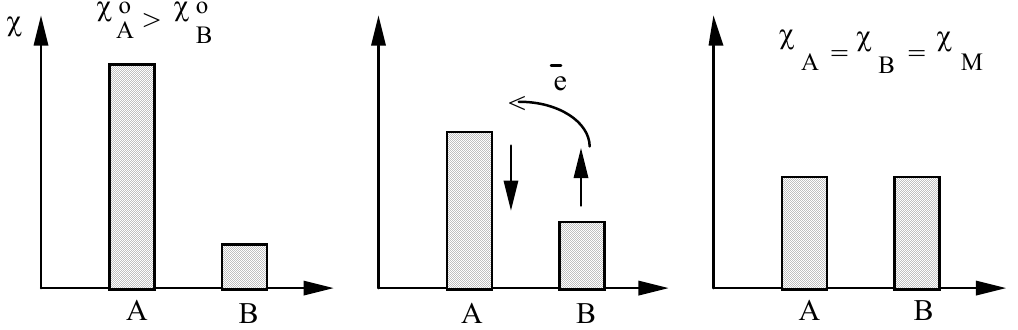
Figure 6 : Sanderson's Electronegativity Equalization